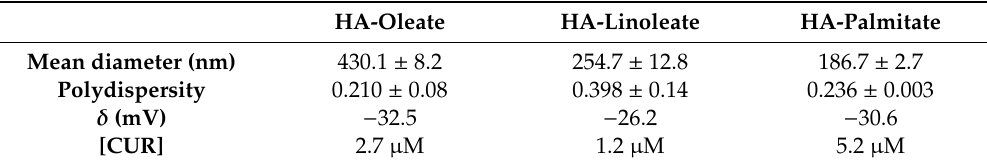
Table 1. Characteristic parameters of CUR-HA-fatty acid conjugates.